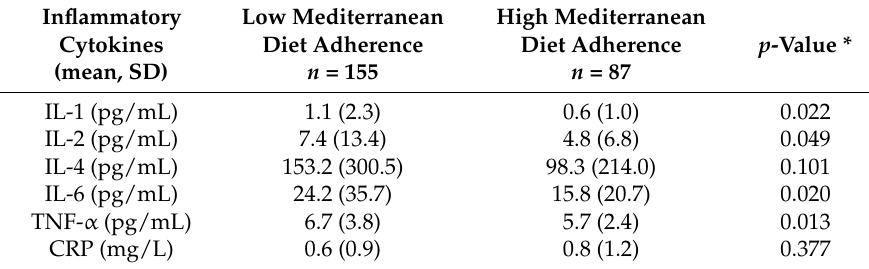
Table 2. Inflammatory markers in adolescents with low and high adherence to the Mediterranean diet.